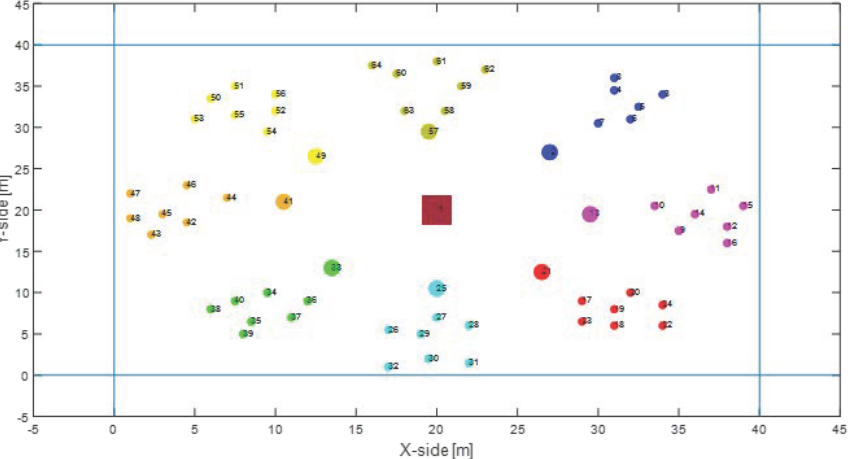
Figure 11. Two-Tier star-based nodes deployment, where clusters are highlighted in different